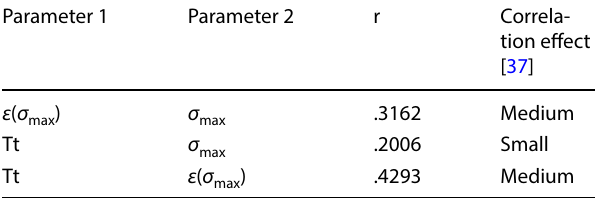
r , Correlation coefficient; ε ( σ stress; σ , tensile strength; Tt, max